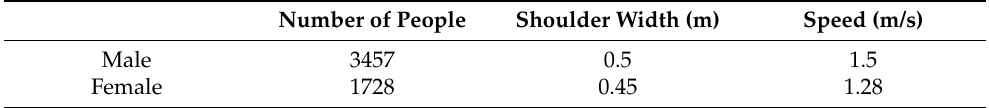
Table 3. Personnel parameter setting.